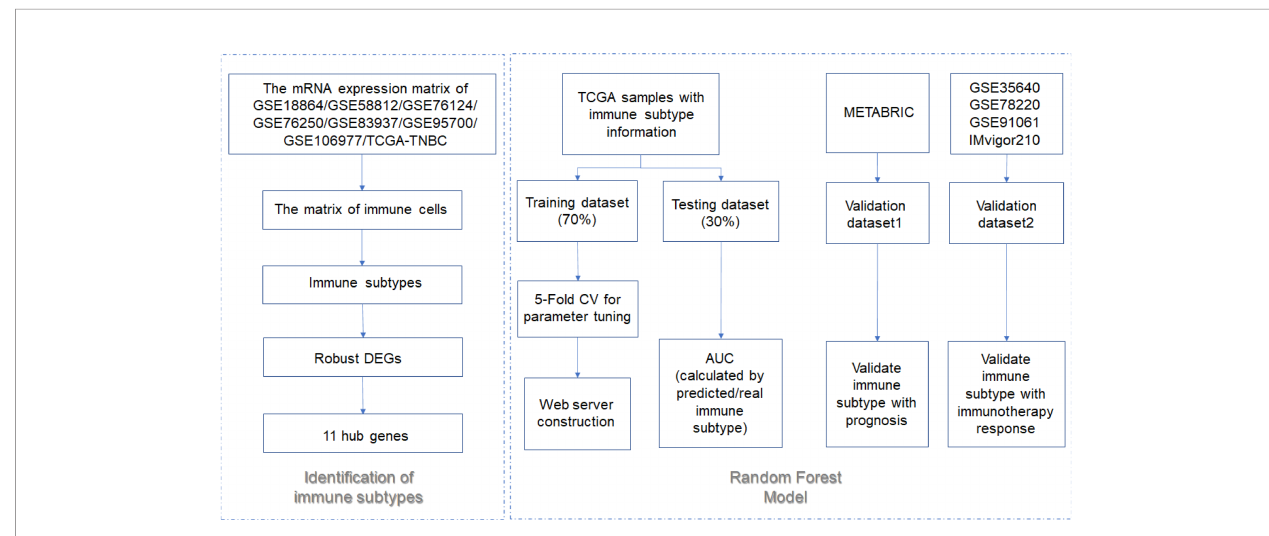
FIGURE 1 | The fl owchart of this